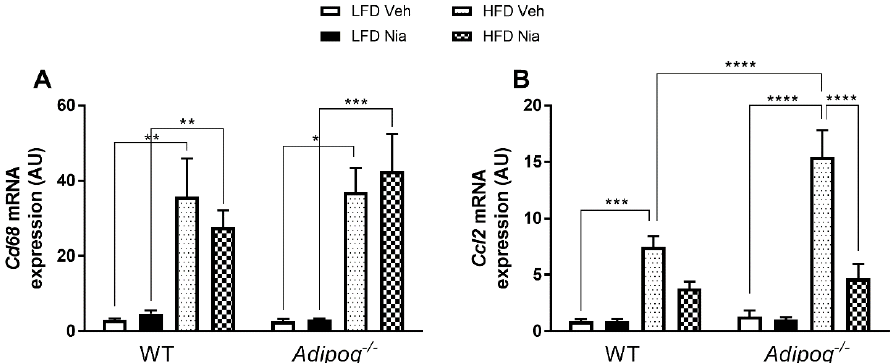
Figure 3. E ff ects of HFD and niacin on the gene expression of markers of macrophage number and migration in EWAT. Relative gene expression of the general macrophage marker Cd68 ( A ) and the macrophage chemokine Ccl2 ( B ) in wild-type and Adipoq - / - mice; all mRNA values were normalized to Rppl0 expression. Data are presented as mean + SEM. AU: arbitrary units. * p ≤ 0.05; ** p ≤ 0.01; *** p ≤ 0.001; **** p ≤ 0.0001; WT LFD Veh, n = 8; WT LFD Nia, n = 8; WT HFD Veh, n = 8; WT HFD Nia, n = 7; Adipoq - / - LFD Veh, n = 6; Adipoq - / - LFD Nia, n = 7; Adipoq - / - HFD Veh, n = 8; Adipoq - / - HFD Nia, n =